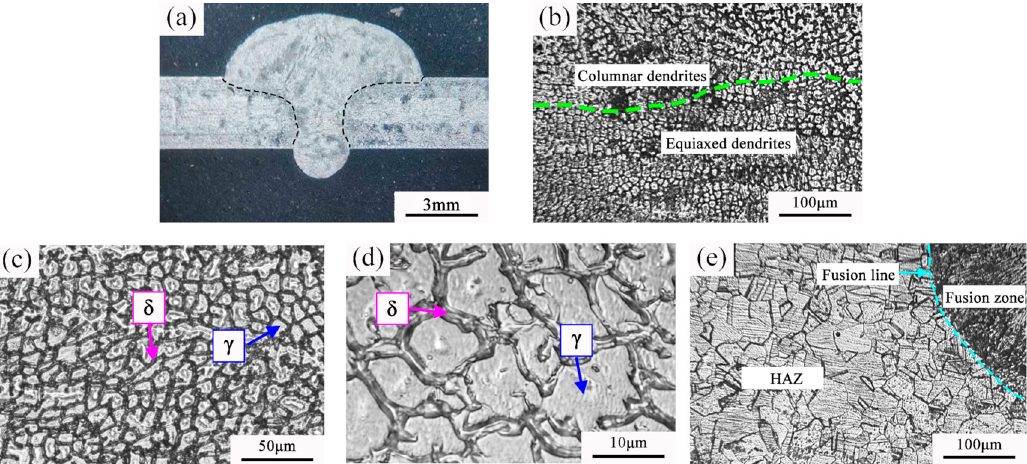
Figure 17. Optical micrographs of microstructure and HAZ of DP-GMAW (No.3): ( a ) weld cross-section; ( b ) typical microstructure of DP-GMAW weld, ( c ) austenite equiaxed dendrites structures, ( d ) ferrite morphology and ( e ) HAZ.